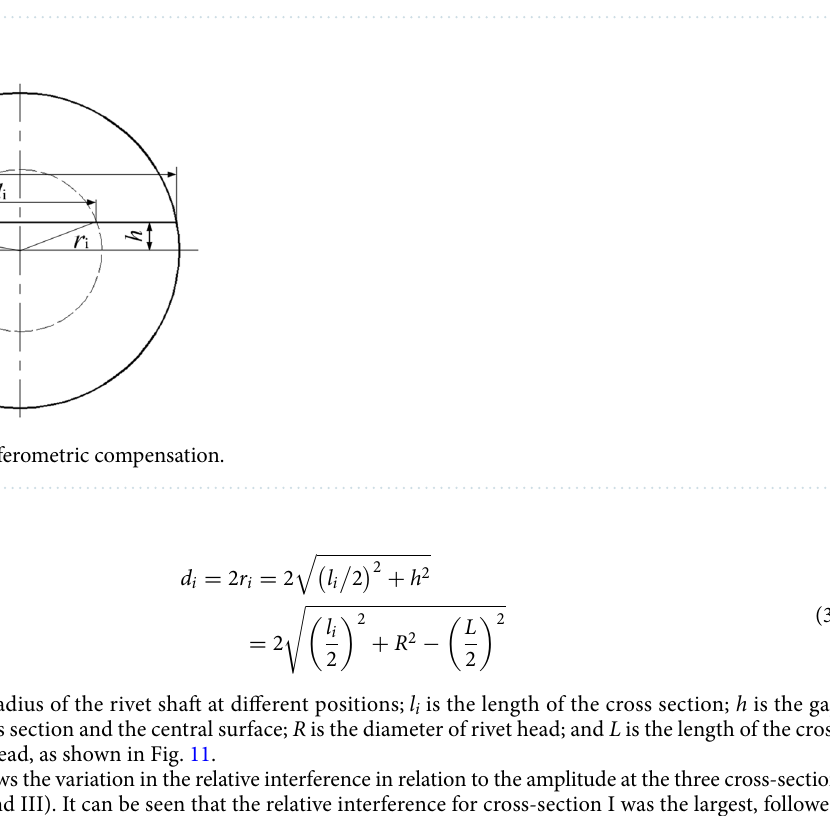
Table 3. Dimensions of three positions under different amplitude conditions.